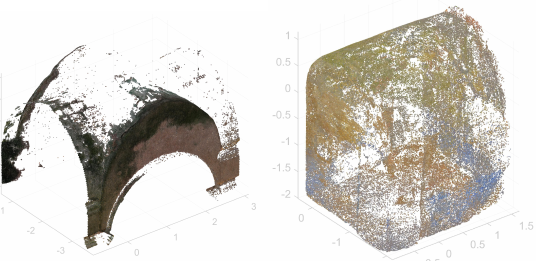
Figure 4 . Example of one of the three inaccurately segmented clusters on Case 1 (left) and Case 3